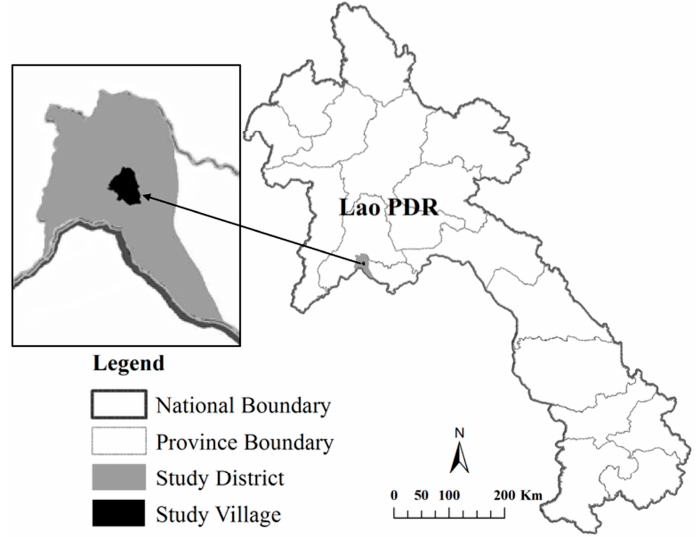
Figure 1. Location map of the case study village. Source: Author’s drawing based on GIS database from MONRE and MAF.